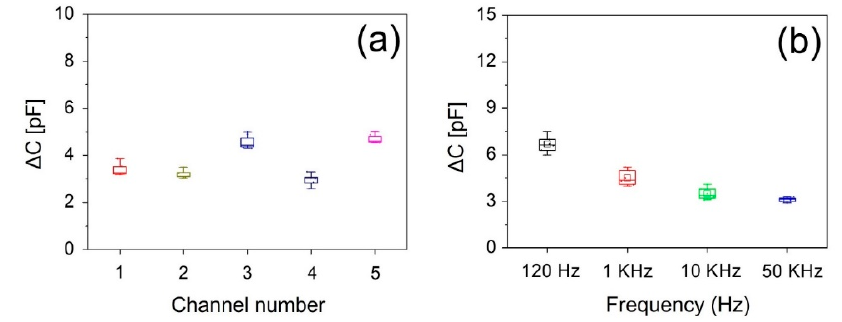
Figure 8. ( a ) Touch sensor-induced change in capacitance [ △ C] for each channel, and ( b ) touch sensor-induced change in capacitance [ △ C] for various frequencies.